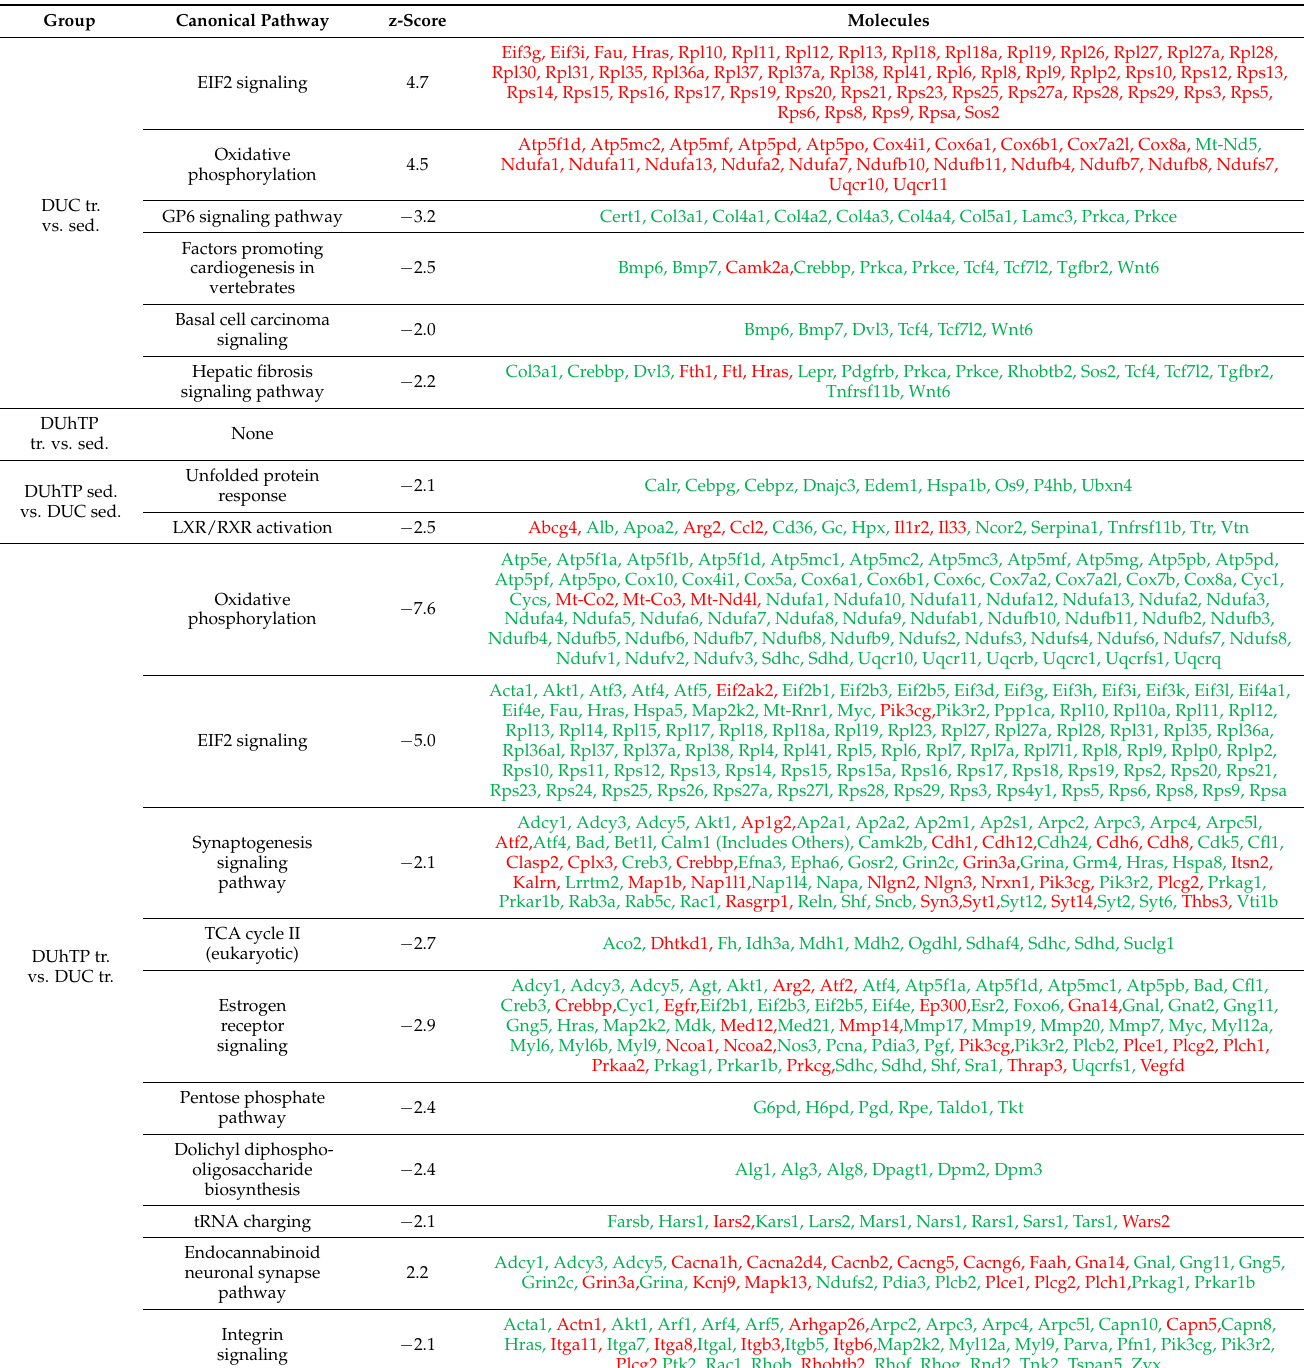
Table 3. Significantly, enriched canonical pathways (Fisher’s exact test adjusted p -value ≤ 0.05) were deduced from DEGs of the pituitary gland in all comparison